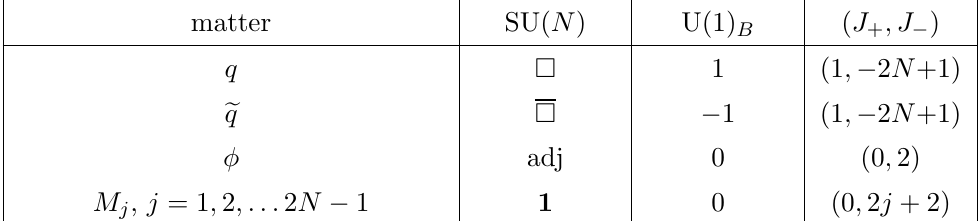
Table 3. The N = 1 matter content for the SU( N ) gauge theory that (cid:13)ows to ( A 1 ; A 2 N (cid:0) 1 ) Argyres-Douglas theory. (cid:26) is again the principal embedding, and j ranges over the exponents of su (2 N ).